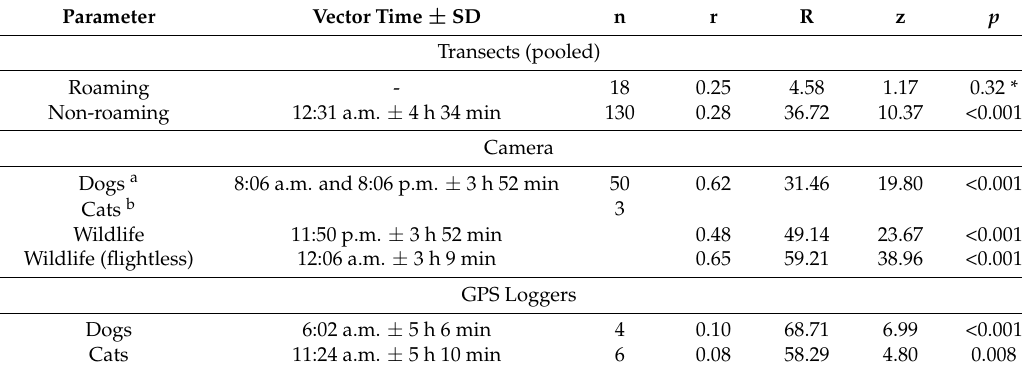
Table 3. Timing of activity. Data is presented as the vector time in which: cats were observed roaming and nonroaming, where n = number of observation; dogs, cats and wildlife were observed roaming on remote-sensing cameras, where n = number of observations and dogs and cats were recorded roaming by GPS loggers, where n = the number of collared animals.